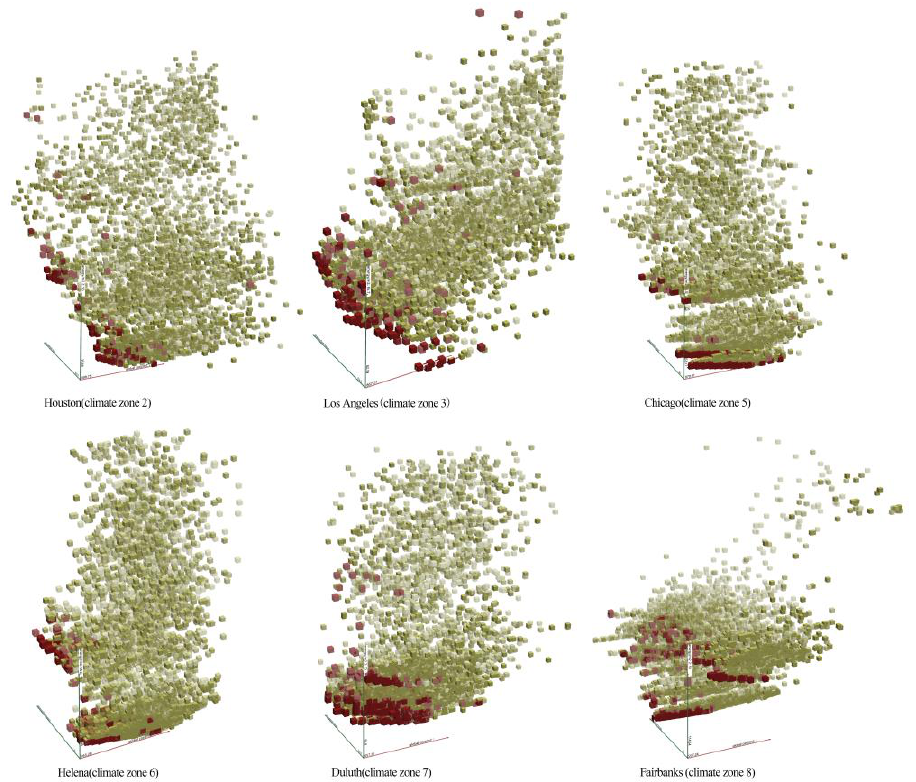
Figure 14. Pareto optimization frontiers of typical cities in the United States.